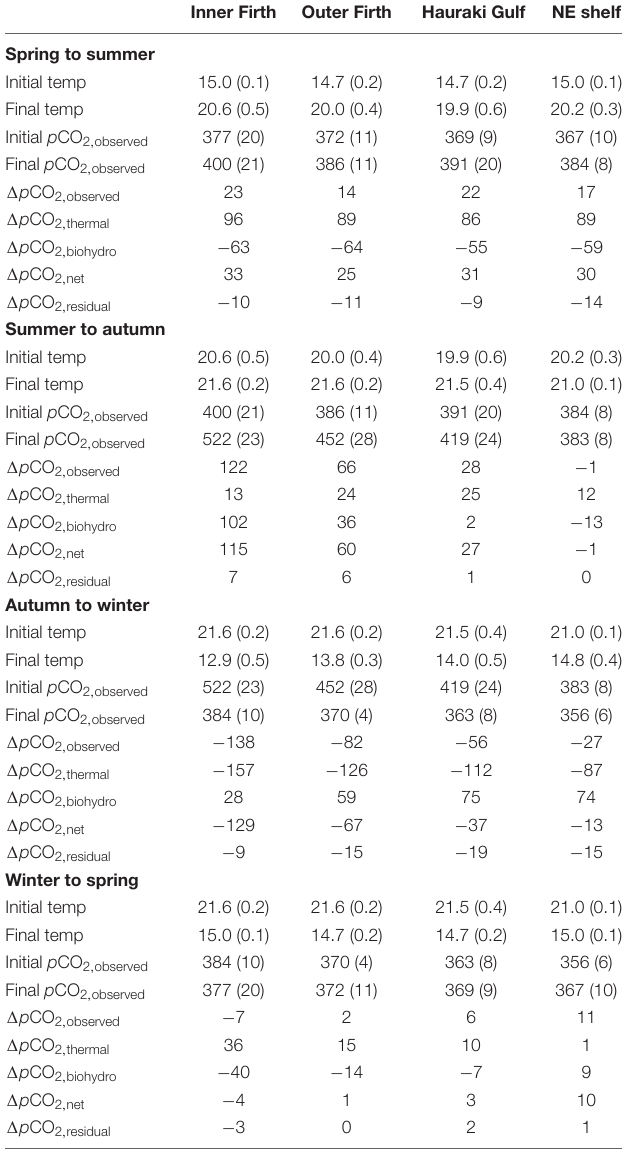
TABLE 2 | Inter-seasonal surface layer temperature ( ◦ C) and p CO 2 ( µ atm) averaged (stdev in parentheses) over inner Firth, outer Firth, Hauraki Gulf and NE shelf regions ( Figure 1B